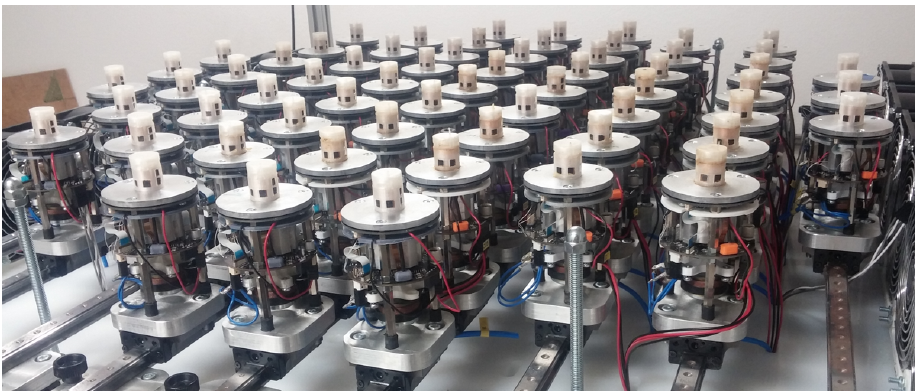
Figure 5. Multi-robot system for interacting with honeybees containing 61 independent devices called CASUs (combined actuator sensor units)